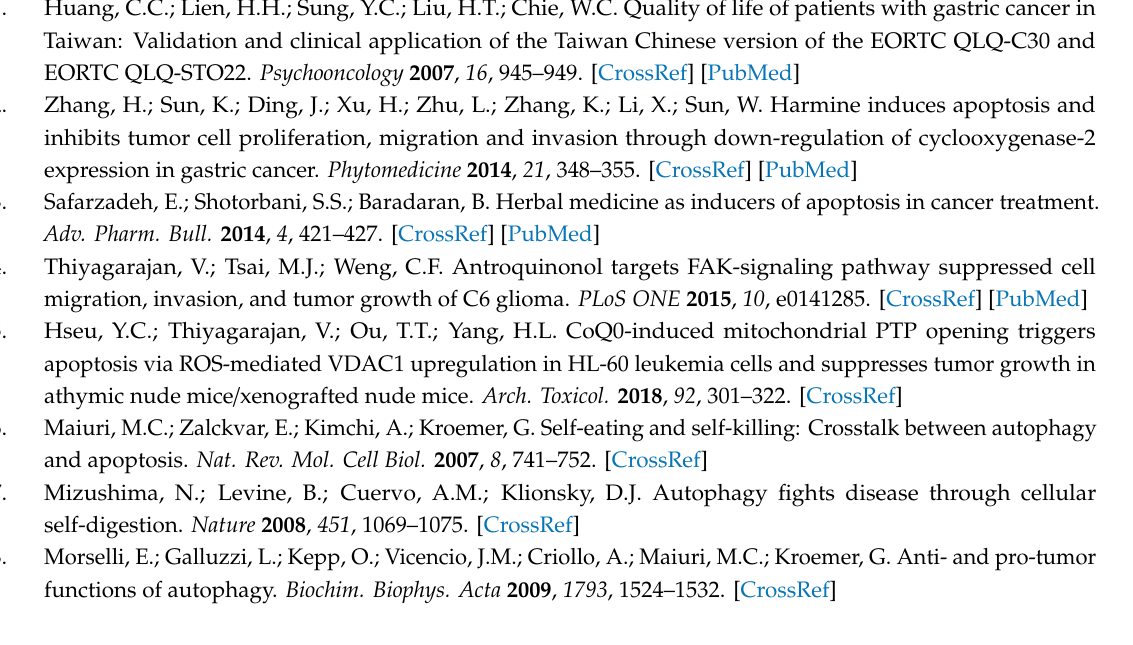
Figure S1. Uncropped Western blot images of the protein content of caspase-3, related to Figure 1C. Figure S2. Uncropped Western blot images of the cytochrome levels c, caspase-3, caspase-9, and PARP, related to Figure 2A. Figure S3. Uncropped Western blot images of the protein levels FasL, Fas, and caspase-8, related to Figure 2C. Figure S4. (A) Uncropped Western blot images of the conversion of LC3-I to LC3-II, related to Figure 4A. (B) Uncropped Western blot images of protein levels in ATG4B. Densitometric analysis measured relative changes in protein bands with the control as 1.0-fold as shown just below the gel data, related to Figure 4E. Figure S5. (A) Uncropped Western blot images of the proteins Bax and Bcl-2. Relative changes in the Bax / Bcl-2 ratio have been measured using commercially available quantitative software with a control representing 1-fold, related to Figure 6A. (B) Uncropped Western blot images of the Beclin-1 and Bcl-2 proteins expression. Relative changes in the Beclin-1 / Bcl-2 ratio were measured by commercially available quantitative software with a control as 1-fold, related to Figure 6B. (C) Uncropped Western blot images of the apoptotic proteins (caspase-3 and PARP) and autophagy markers (LC3-I / LC3-II and p62 / SQSTM1), with co-treatment of 0, 1, 3, 6, 12, and 24 h after FKB (2.5 µ g / mL) and doxorubicin (0.5 µ g / mL), related to Figure 6C. Figure S6. (A,B) Uncropped Western blot images of Inhibition of autophagy caused by FKB / doxorubicin suppressed apoptosis. Cells were pretreated with 3-MA (1 mM), related to Figure 7A,B. (C) Uncropped Western blot images of the monitored changes in the LC3-I / II and caspase-3 expressions, related to Figure 7C. Figure S7. (A,B) Uncropped Western blot images of The e ff ect of FKB and doxorubicin co-treatment on expression of LC3-I / II, caspase-3, and PARP was investigated and then changes in total and phosphorylated levels of ERK and JNK were assessed by Western blot, with caspase-3 and PARP expressions, related to Figure 8A,B. Figure S8. (A) Uncropped Western blot images of the terms caspase-3, PARP, and LC3-I / II, related to Figure 10A. (B,C) Uncropped Western blot images of The monitored for the terms ATG4B and p-ERK, related to Figure 10B,C. Figure S9. (A) Uncropped Western blot images of the the